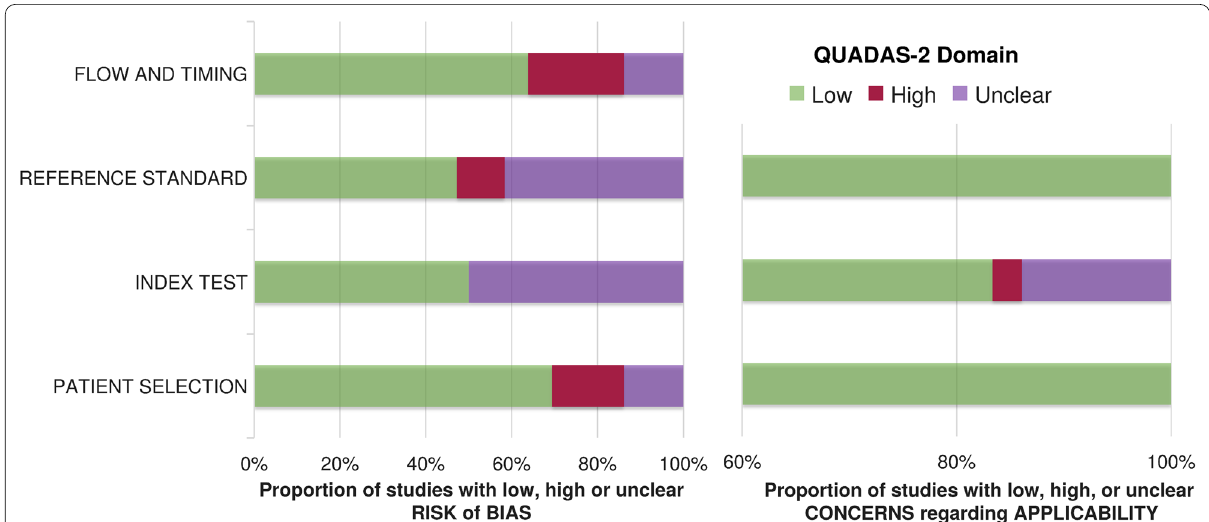
Fig. 4 Summary results of QUADAS-2 tool on risk of bias and applicability concerns for the included studies in the present systematic